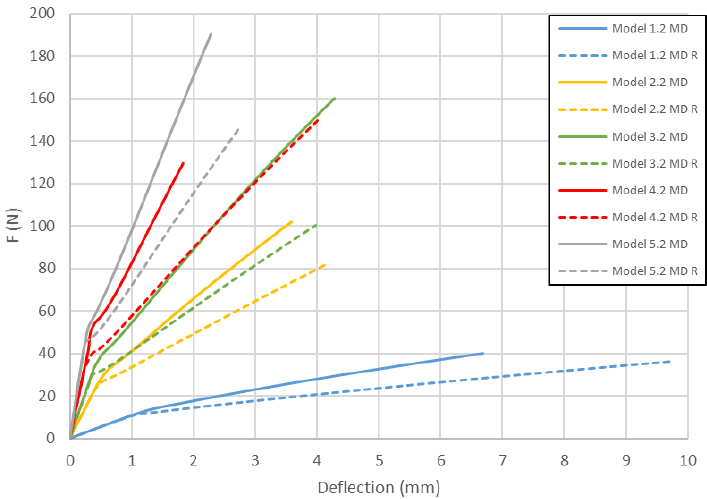
Figure 14. Comparison of curves of all considered cases in MD.